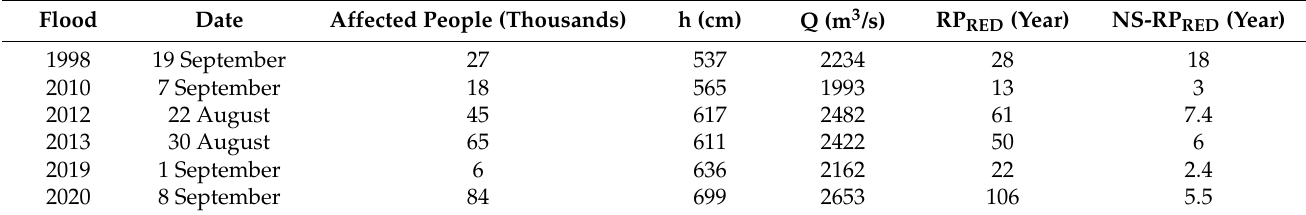
Table 6. Riverine floods events and related return periods of red AMAX causing damages in Niamey in the past decades. Source of affected people: 1998 – 2020 BDNIA [30].